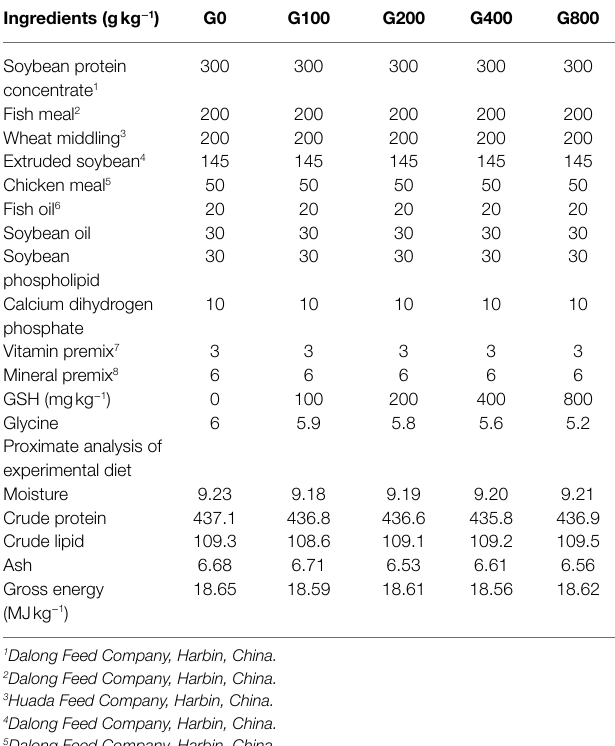
TABLE 1 | Formulation and chemical proximate composition of the experimental